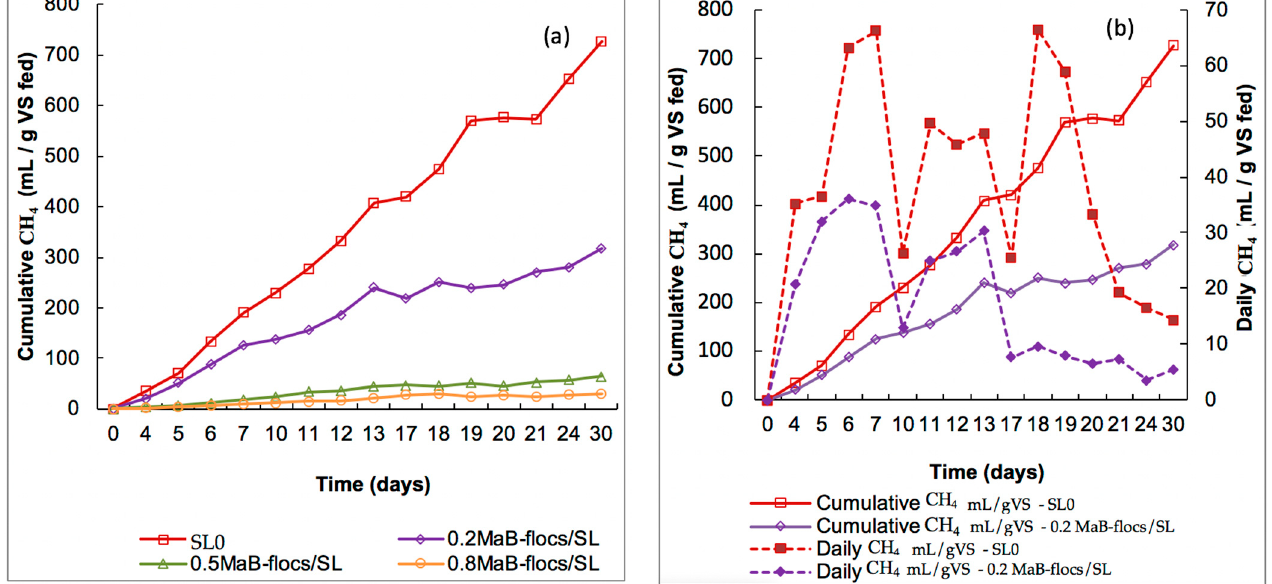
Figure 5. ( a ) Cumulative methane production from slurry as control and different ratios of Ma-B flocs/Slurry (Ma-B flocs/SL). ( b ) Daily and cumulative methane production for Slurry control and ratio 0.2 Ma-B flocs /Slurry.